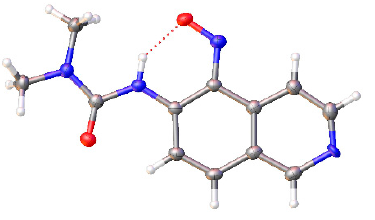
Figure 2. ORTEP diagram of nitroso compound 10a. The crystallographic data could be found in the Supplementary Materials.